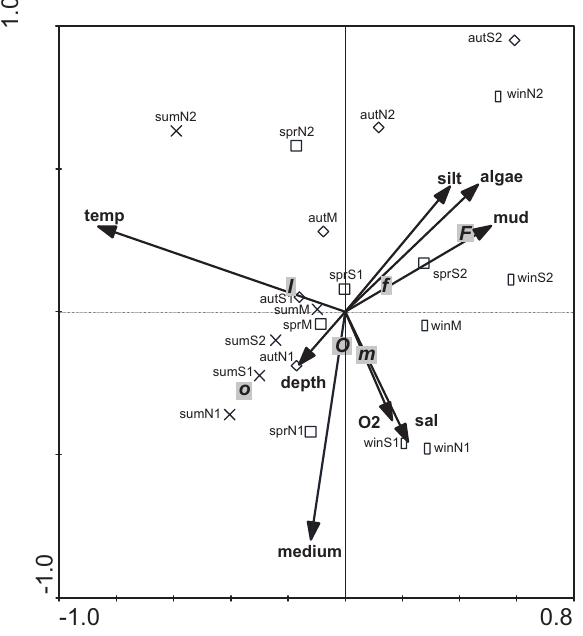
1 . - -1.0 0.8 F IG . 5. – Ordination diagram for the two canonical axes of the corre- spondence analysis performed using Crangon crangon density data ( I , immature CL<3.5 mm; f , female CL<7.7 mm; F , female CL>7.7 mm; m , male; o , berried female CL<7.7 mm; O , berried female CL>7.7 mm; temp, temperature; sal, salinity; algae, algae cover; mud, % of mud; silt, % of silt; medium, % of medium sand; O2, dis- solved oxygen; sum, summer; aut, autumn; win, winter; spr, spring; M, sampling station M; S1, sampling station S1; S2, sampling station S2; N1, sampling station N1; N2, sampling station